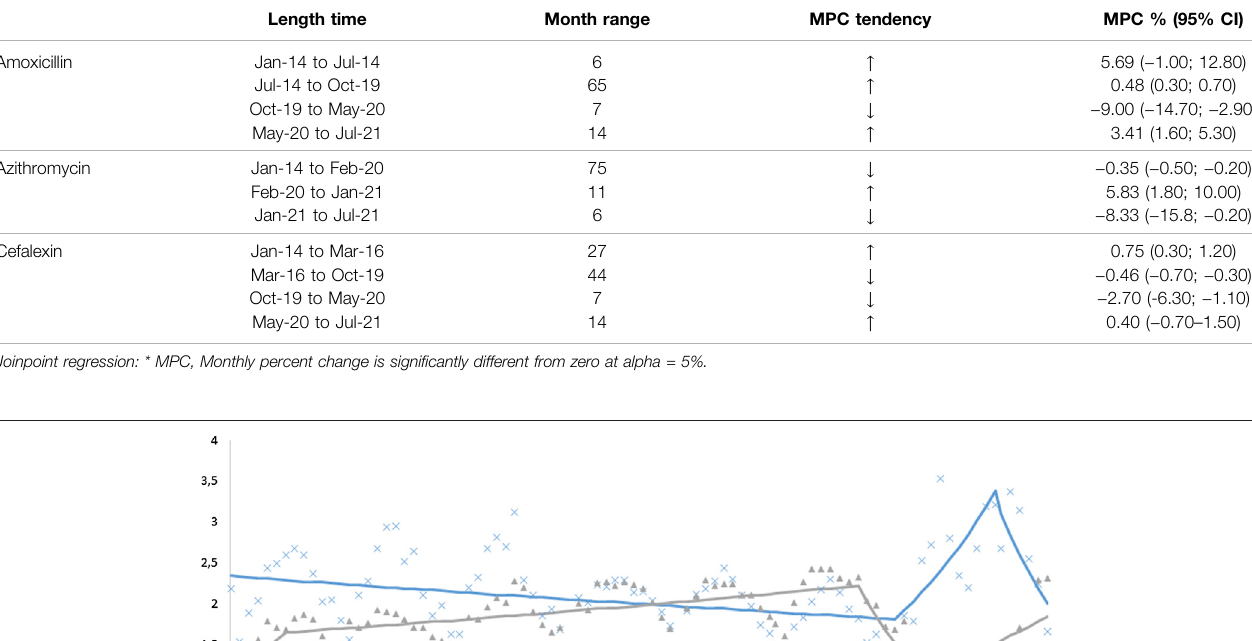
TABLE 3 | Joinpoint analysis for amoxicillin, azithromycin, and cefalexin sales in Brazil by month, January 2014 to July 2021.